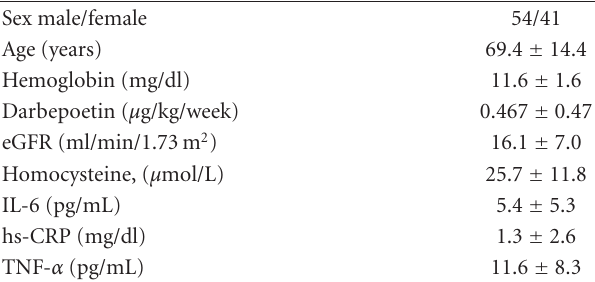
Table 1: Clinical, biochemical, and nutritional data. Table 2: Correlation between Hcy and inflammatory/nutritional parameters and level of renal function (Pearson correlation).